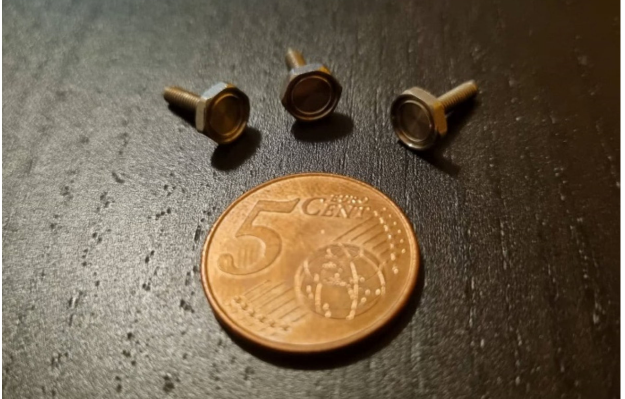
Figure 3. ES-40 Bearings by Swiss Jewel.